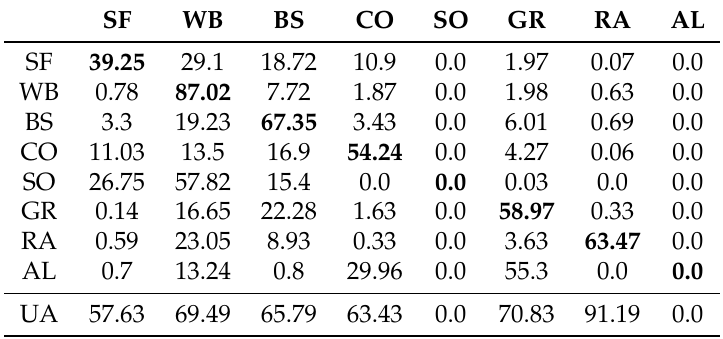
Table 7. Confusion matrix for 29-01-2015 using Landsat8 alone (4 images). κ = 0.58.